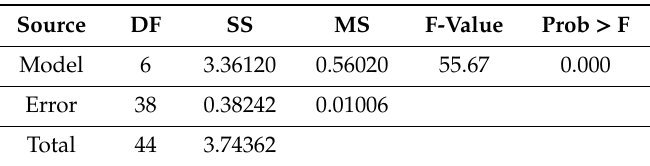
Figure 2. Plots showing the synergistic effect of oxacillin/palmitic acid/span85 on cell growth. ( A ) Oxacillin ( μ g/mL), palmitic acid (mg/mL); ( B ) palmitic acid (mg/mL), span85 (%); ( C ) oxacillin ( μ g/mL), span85 (%). Table 3. Analysis of variance for the selected model.